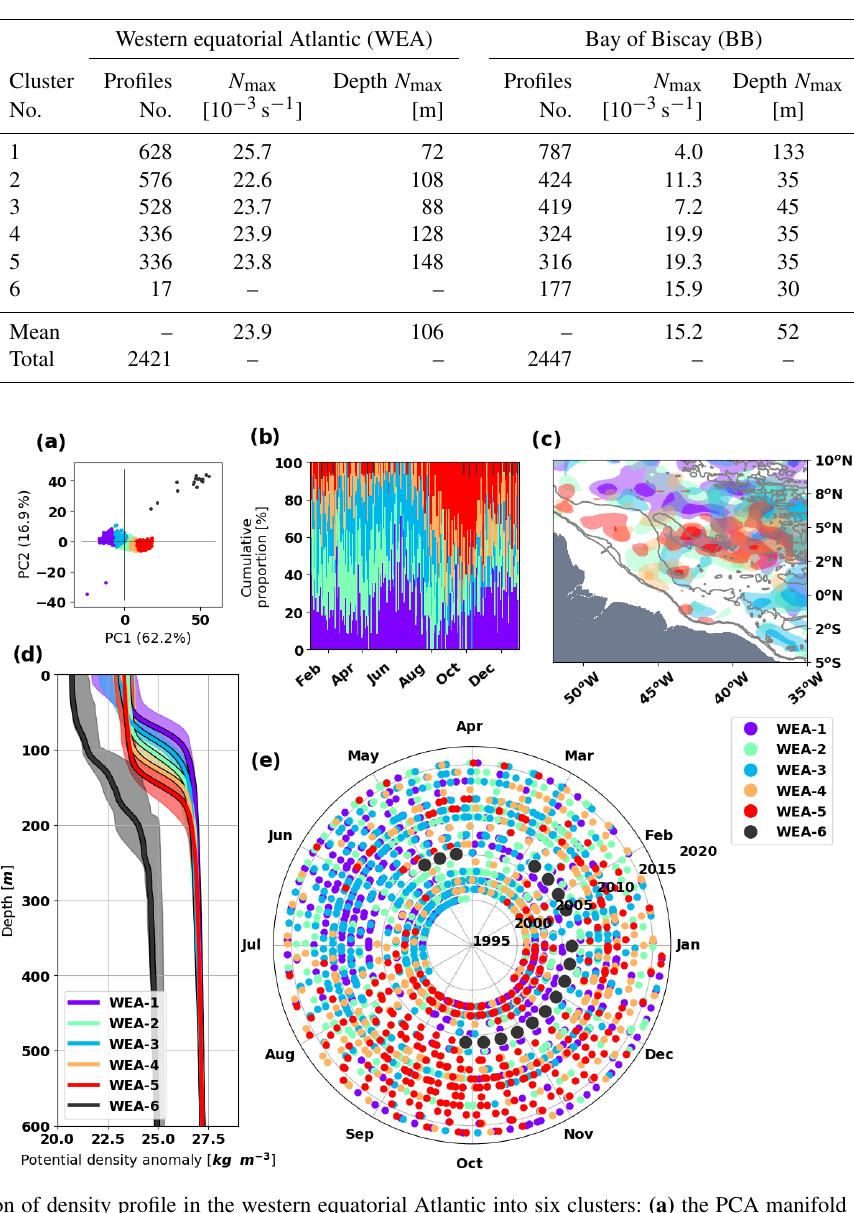
Figure 2. Classification of density profile in the western equatorial Atlantic into six clusters: (a) the PCA manifold of the profiles, (b) the cumulative proportion of the clusters during a mean year, (c) the spatial distribution, (d) the median and the 90% interval of each cluster, and (e) the measurement dates of the density profiles (the angles represent the day of the year, the distance from the center and the year of measurement). The colors of the clusters are common to all the graphs. The colored contours of (c) are set to highlight the areas gathering from two to five profiles (light color) and over five profiles (bold color) for each cluster. The gray contours of (c) show the 200, 1000 and 4000m